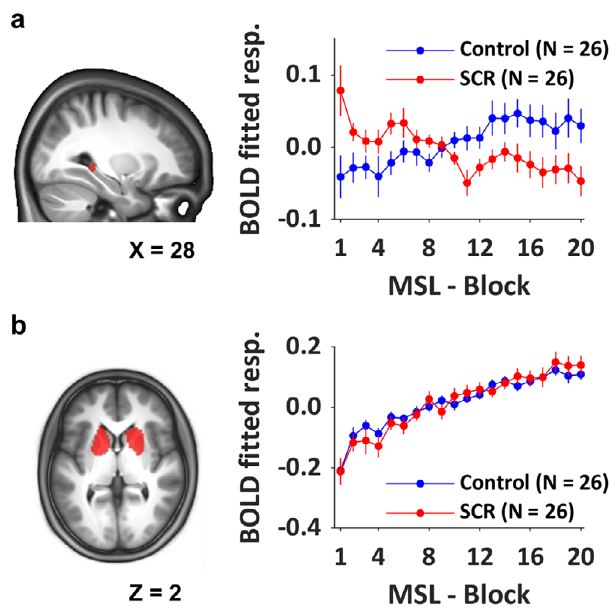
Fig. 5 Linear modulation of brain responses by performance speed. To show the modulation effect across blocks of practice, the β -estimate was multiplied with the modulation regressor vector and data were then averaged across time points within each block of practice. It is noteworthy that due to missing fMRI data, one extra control participant was excluded. a Effect of stress on HC dynamical activation ([30 − 36 − 2mm], 69 voxels, Control vs. SCR, T = 3.05, p SVC = 0.036). The averaged BOLD fi tted response shows that right HC activation decreased more across blocks of practice in the stress group as compared to controls. b Across groups, bilateral STR responses increased with performance speed improvement. For illustrative purposes, the graph depicts the groups separately and the averaged BOLD fi tted response is based on the right dorsal putamen ([22 16 2 mm]) but other clusters exhibited similar results (see Supplementary Table 5 for all clusters). Error bars indicate SEM in both panels. For display purposes, activation maps are overlaid on a T1-weighted template image with a threshold of p < 0.005